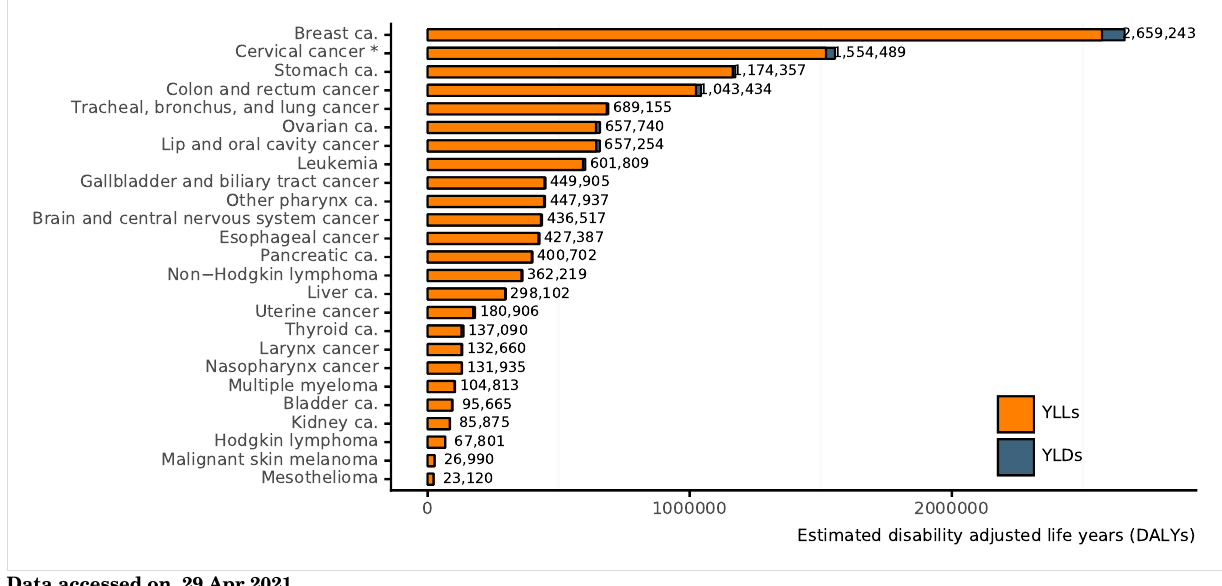
Figure 14: Comparison of annual premature deaths and disability from cervical cancer in India to other cancers among women (estimates for